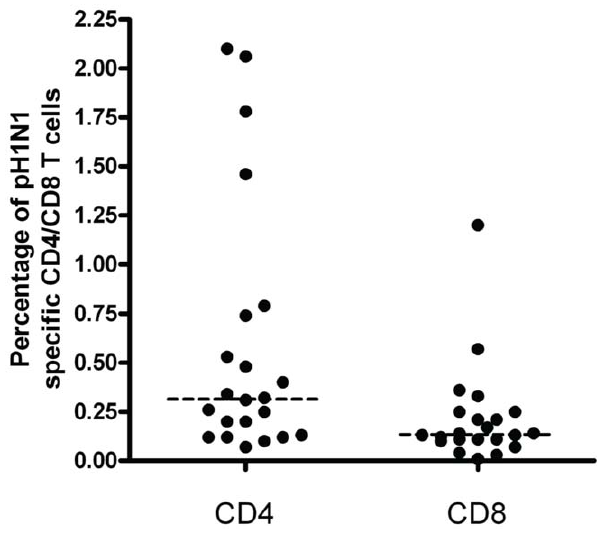
Figure 1. Range of pH1N1-specific CD4 + IFN c + and CD8 + IFN c + T cell frequencies (%) in peripheral blood mononuclear cells of individual patients (n=22). Samples taken after natural pH1N1 infection but prior to the onset of the next influenza season. Horizontal line represents median response.